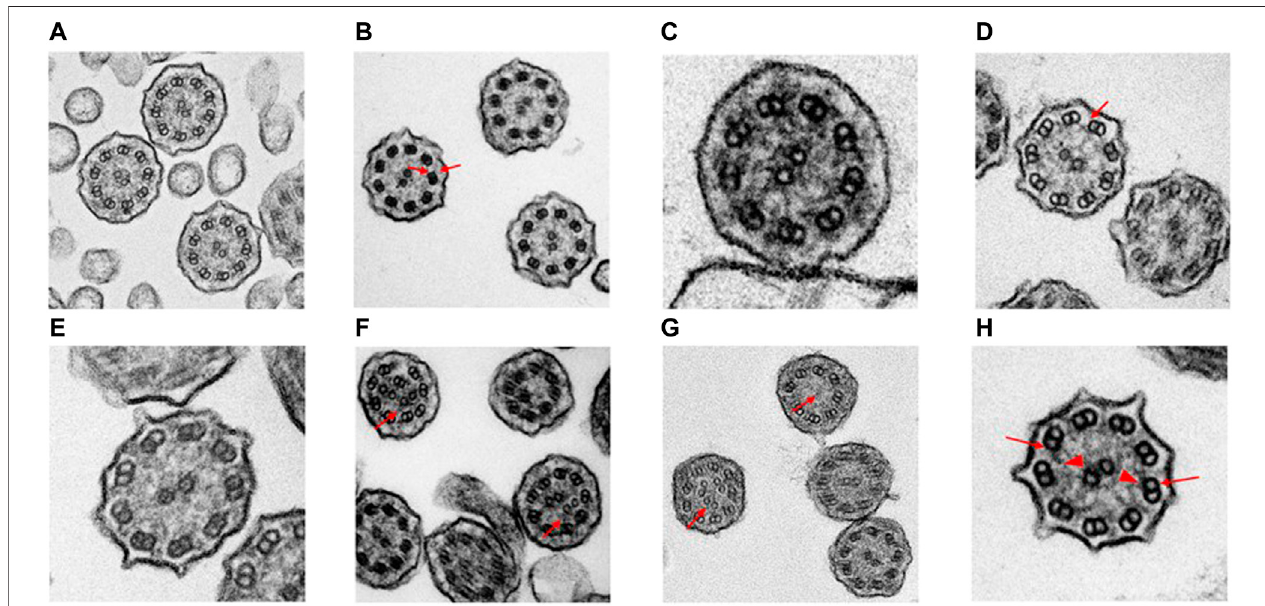
FIGURE2| Transmissionelectronmicroscopyresultsofsuspectedearly-onsetbronchiectasispatientsinHongKong. (A) Case12 — Con fi rmedCFcaseshoweda normal ciliary ultrastructure. (B) Case 5 — A homozygous recessive DNAAF3 c 493G > C variant was identi fi ed. TEM results showed an outer and inner dynein arm (arrows)defectwhichissimilartopreviouslyreportedcases (C) .Case25ciliaproximalarm — Acompoundheterozygousvariantscouldbeseenin DNAH9. Theliterature has shown that subtle outer dynein arm defect can be seen in TEM. The ciliary ultrastructure analysis in the proximal arm shows a normal ultrastructure (D) . Case 25ciliadistalarmshowsasubtleouterdyneinarm(arrow)defect.(E) Case63 — TEMresultsshowed anormalciliaryultrastructure.Apathogenichomozygousrecessive DNAH11 c.11749_11752delGTTA was identi fi ed and con fi rmed the clinical diagnosis despite the normal ultrastructure. HSVM showed a static beat pattern in 50%